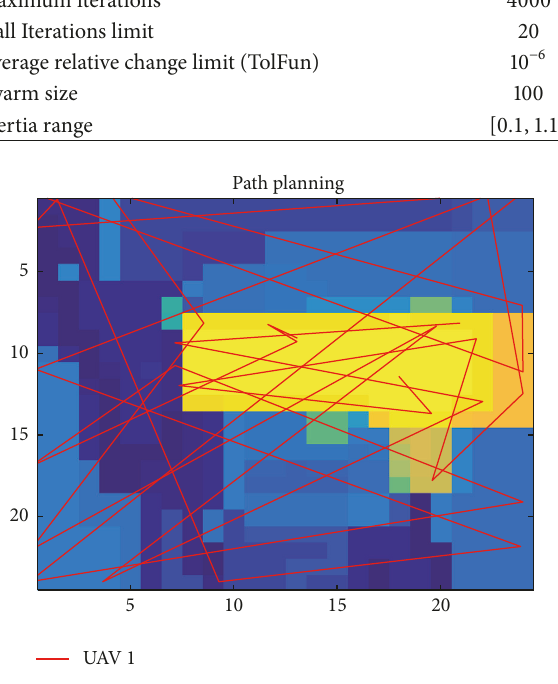
Figure 11: La Palma PSO path